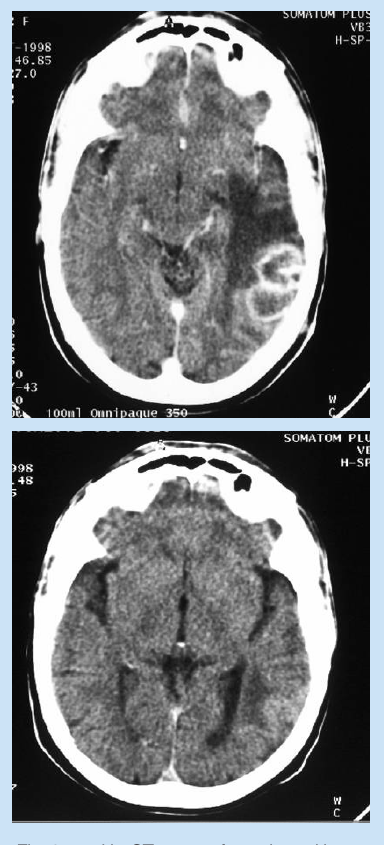
Fig. 2a and b. CT scans of a patient with pre- sumed TB at presentation (top) and on anti- TB treatment after 6 weeks